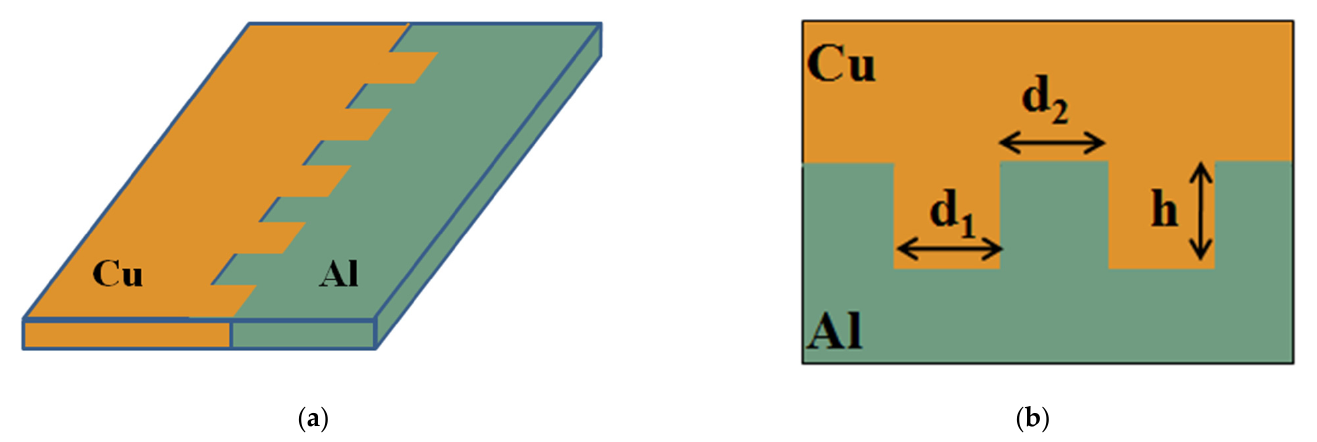
Figure 20. ( a ) schematic diagram of tooth ‐ shaped butt joint; ( b ) Dimension diagram.